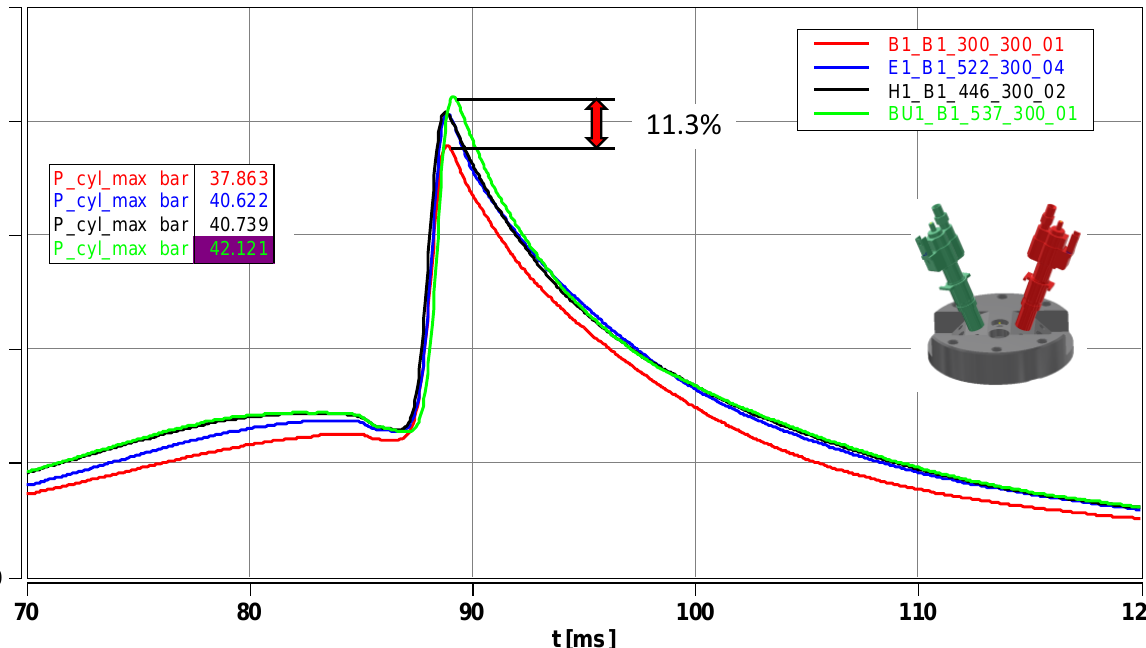
Figure 5. Compilation of the pressure values in the combustion chamber of a rapid compression machine during the combustion of gasoline with other fuels along with the maximum obtained values.